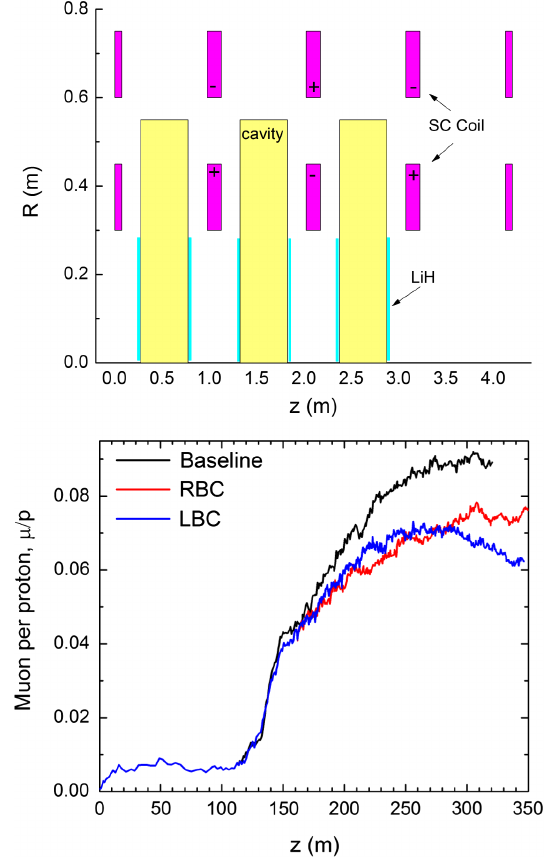
FIG. 7. Schematic of a bucked coil lattice in radially bucked coil (RBC) arrangement and simulated good muon yield with radially bucked coil and laterally bucked coil (LBC) lattices. The bucked coils were used also in the phase rotation section in these